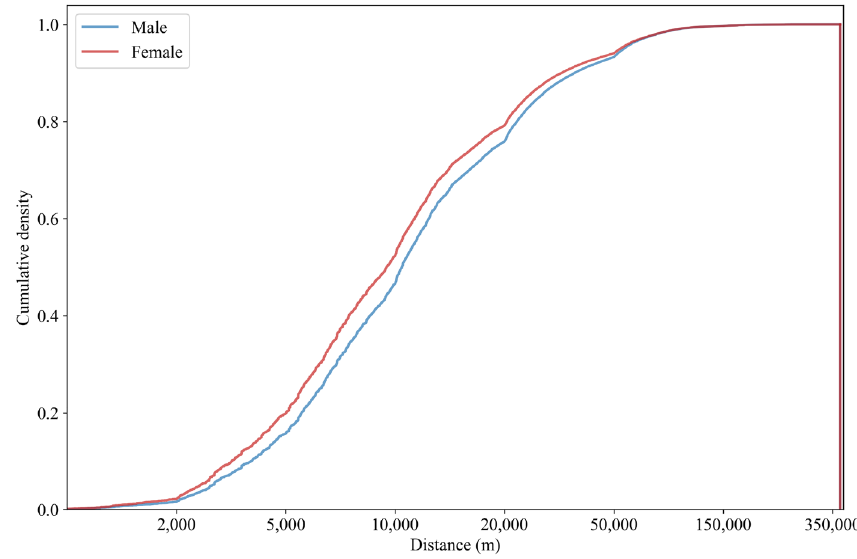
Figure 5. Distribution of trip distances across genders.